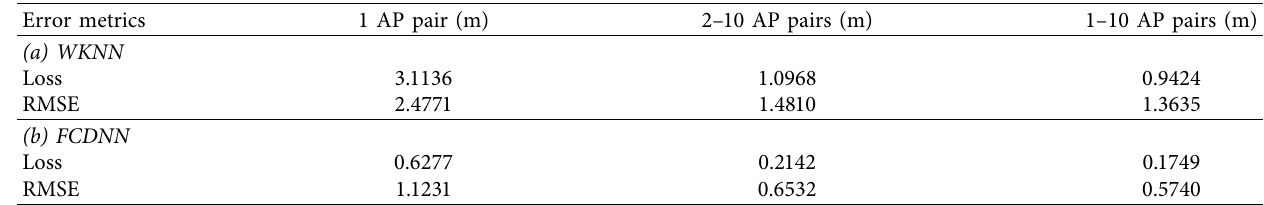
Table 6: Te error metrics (a) WKNN and (b)